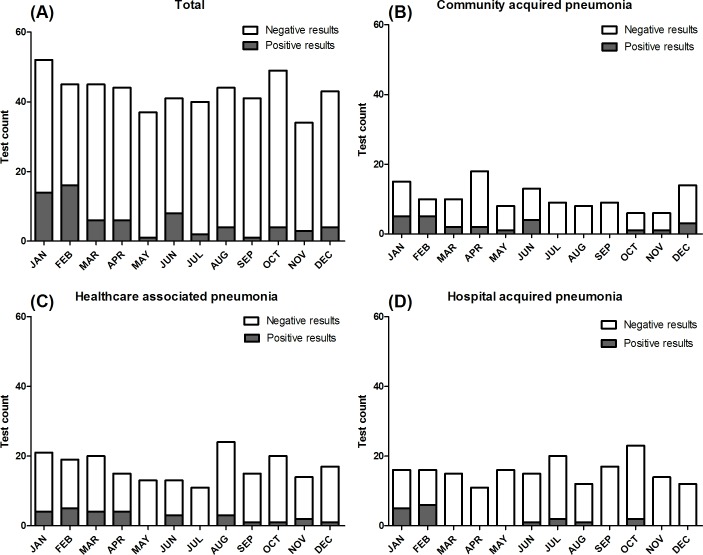
Detection of respiratory viruses by month and pneumonia category.The shaded bars represent positive results, and the white bars represent negative results. Detection rate was highest in February and January. (A) Total patients. (B) Community acquired pneumonia patients. (C) Healthcare associated pneumonia patients. (D) Hospital acquired pneumonia patients.